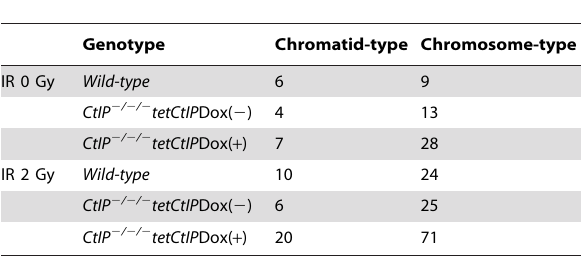
Table 1. Chromosomal aberrations in CtIP 2 / 2 / 2 tetCtIP